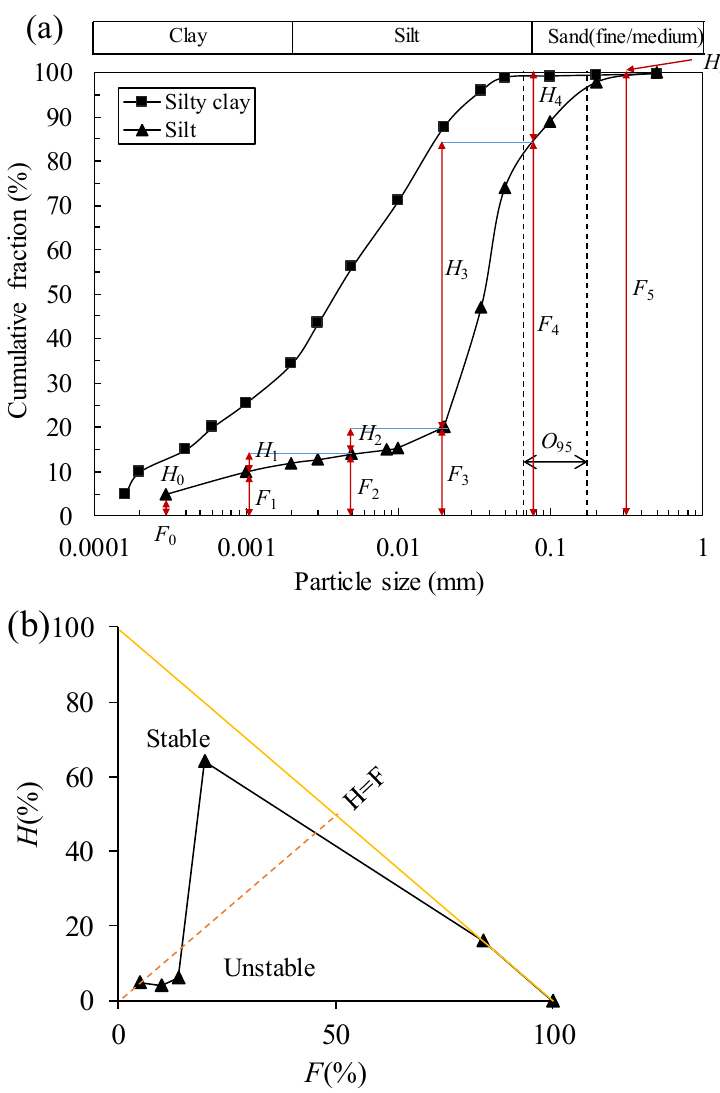
Figure 2. Gradations of the natural soils: ( a ) particle size distribution curve of silty clay and silt, and coordinates for the construction of silt internal stability graphs according to Kenney and Lau (1985) [24]; ( b ) internal stability of silt graphs according to Kenney and Lau (1985) [24]. Table 2. Descriptions of the natural soils. Parameter Silty Clay